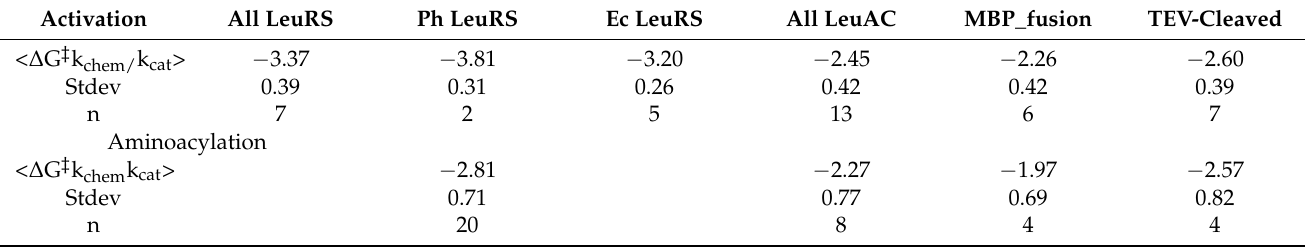
Table 4. Variation of first-order and turnover rates for amino acid activation and tRNA Leu aminoa- cylation by LeuRS, MBP-LeuRS and TEV-cleaved LeuRS. Mean values of ∆ G ‡ k chem/ k cat = –RT ln(k chem/ k cat ) with standard deviations and numbers of assays are given for the different